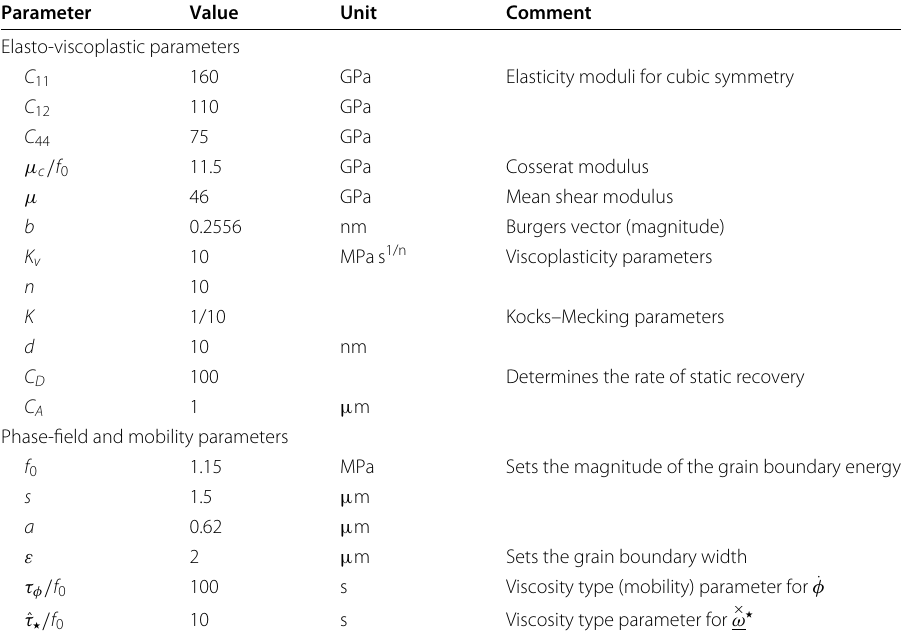
Table 1 Model parameters used in the simulations Parameter Value Unit Comment Elasto-viscoplastic